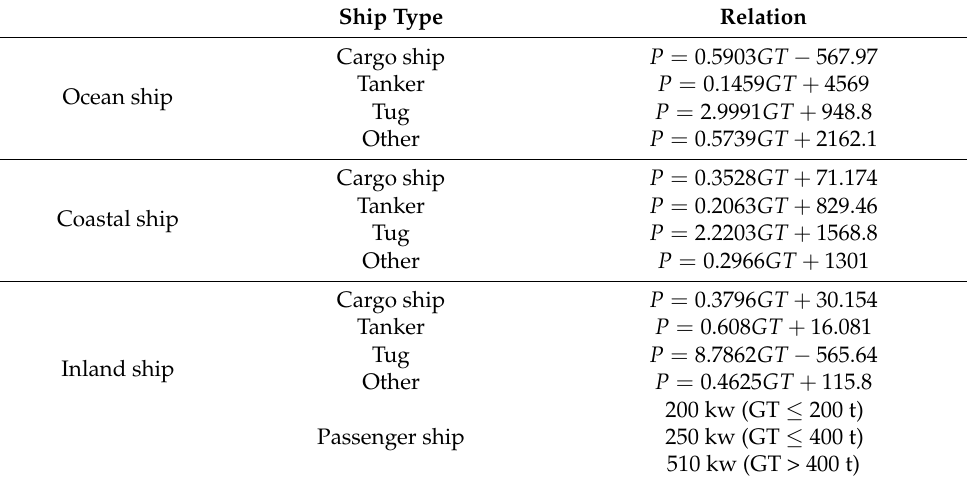
Table 5. Relationship between GT and